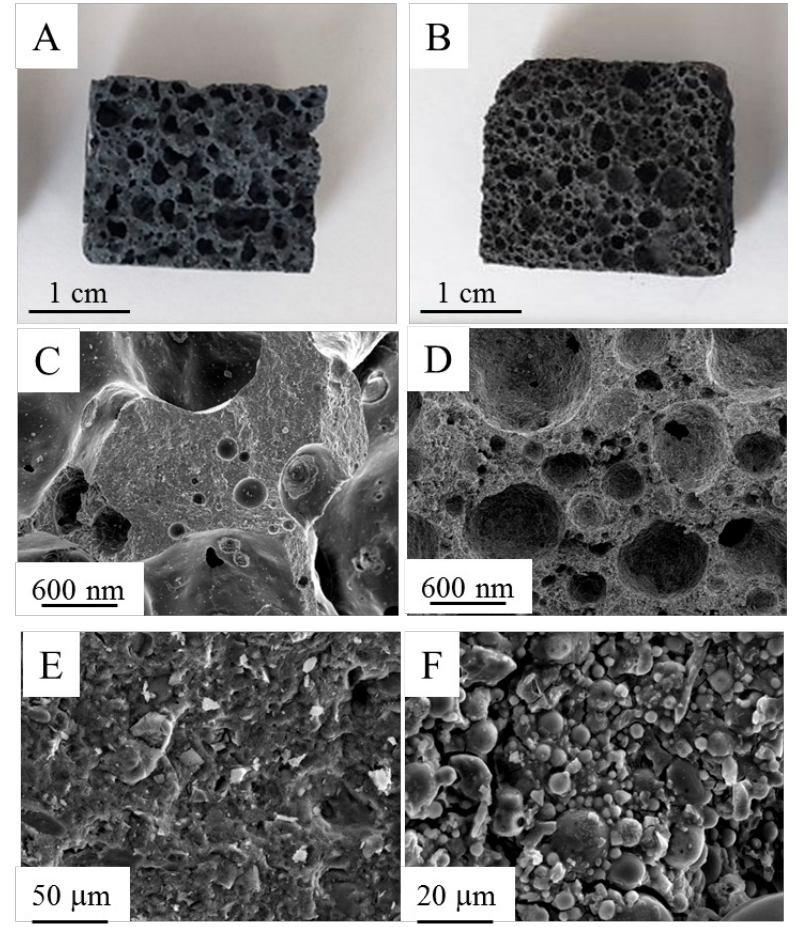
Figure 8. Digital photographs and related microstructure of: ( A , C , E ) HL-R; ( B , D , F ) FA-R. Both porous samples contain Al at 0.1%.